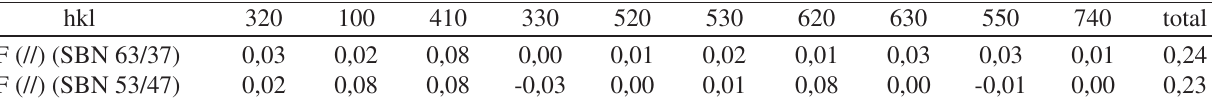
Tabela 1. Fator de Lotgering F, das famílias de planos perpendiculares aos planos [00l] entre 20° < 2 Θ < 60°, em cerâmicas de SBN FQ